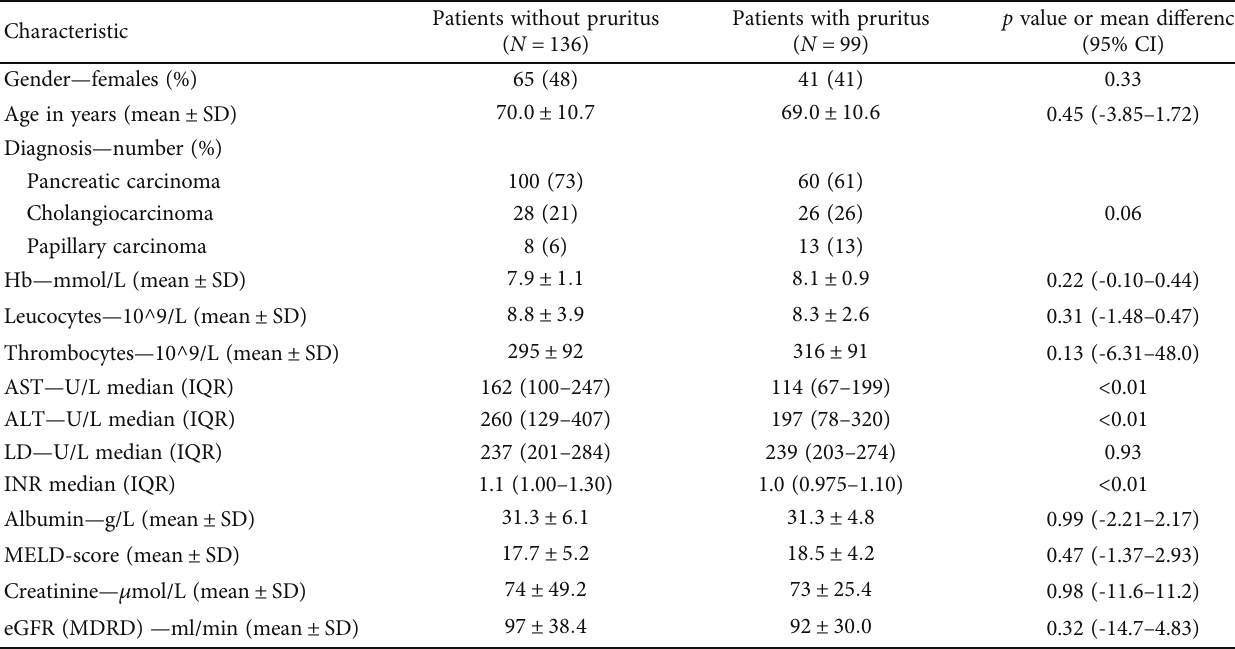
Table 1: Demographic and laboratory characteristics.